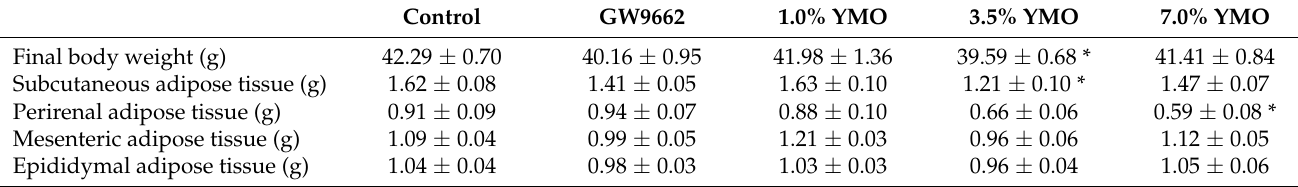
Figure 3. Effect of YMO on the expression of adipocyte or osteoblast marker genes. C3H10T1/2 cells were differentiated and treated with ethanol or YMO (25 µ g/mL) for 14 days. mRNA expression levels of adipocyte marker genes ( A – C ) and osteoblast marker genes ( D – G ) were measured by real-time PCR. Relative mRNA expressions were expressed as percentage of day 0 control. Values are mean ± SE, n = 4–5. ** p < 0.01, * p < 0.05 versus each day control. Table 2. Effect of YMO on final body weight and white adipose tissue weight in KK-A y